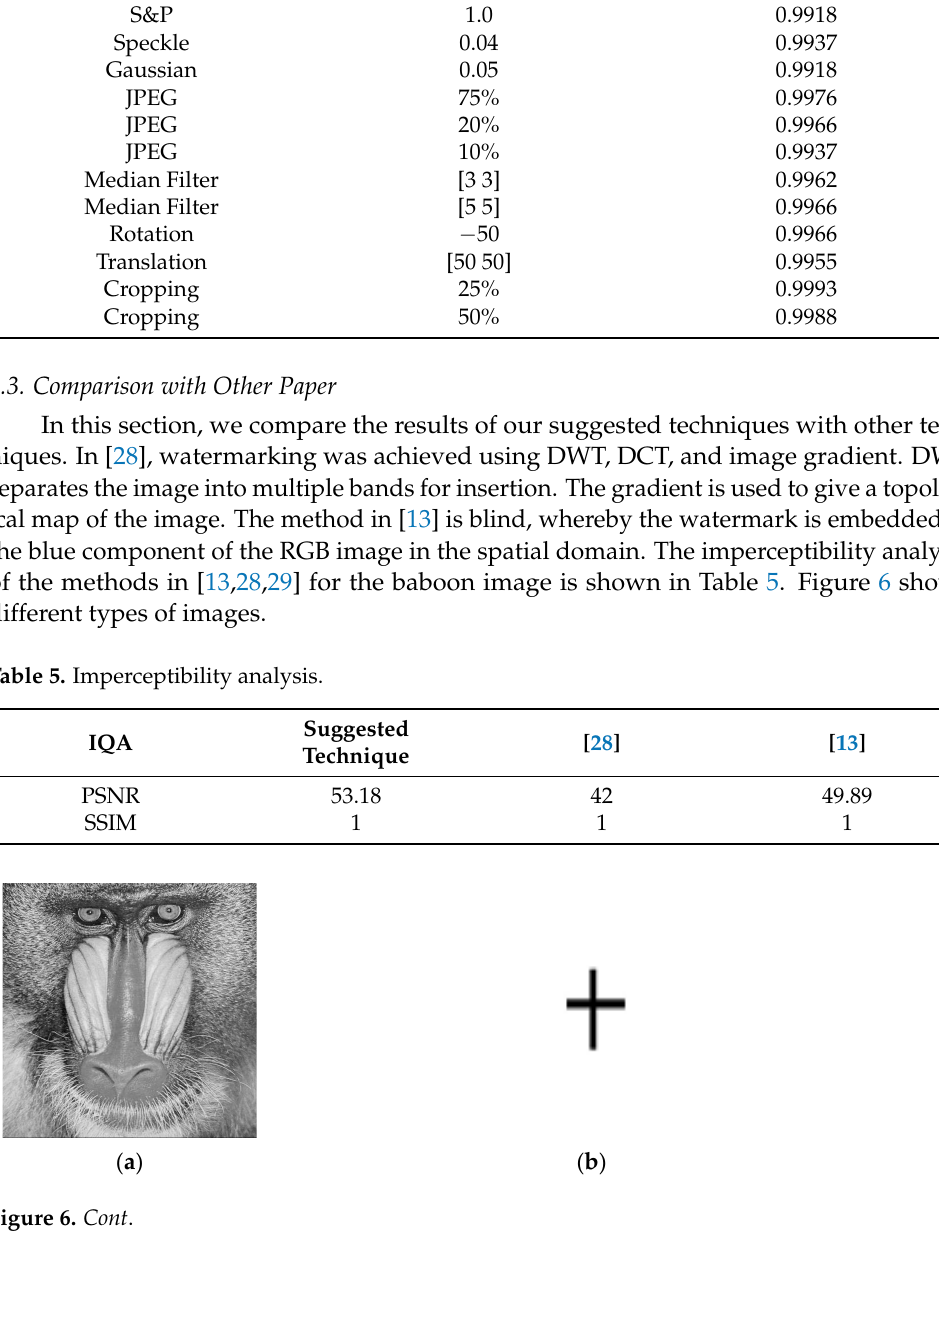
Table 4. Normalized correlation strength.